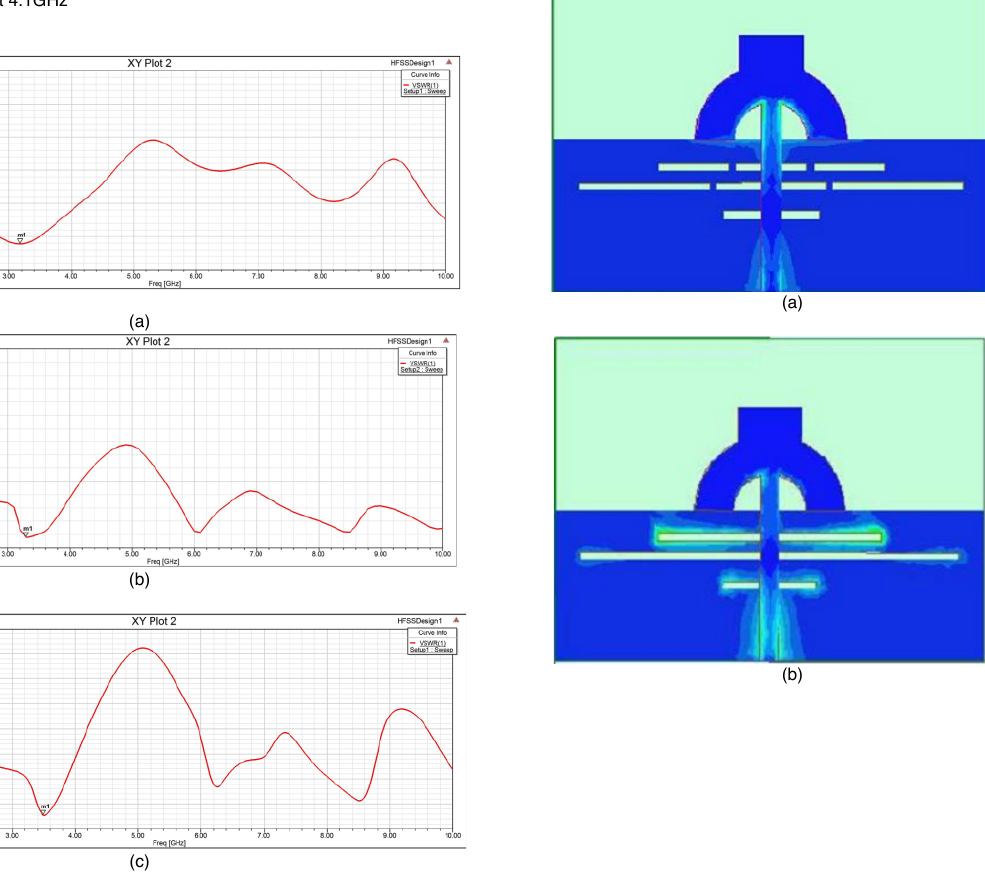
FIGURE 6. Radiation pattern of (a) Whole band (b) Sub-band1 excited at 3.29 GHz (c) Sub- band2 excited at 3.50 GHz (d) Sub-band3 excited at 3.75GHz (e) Sub-band4 excited at 4.1GHz